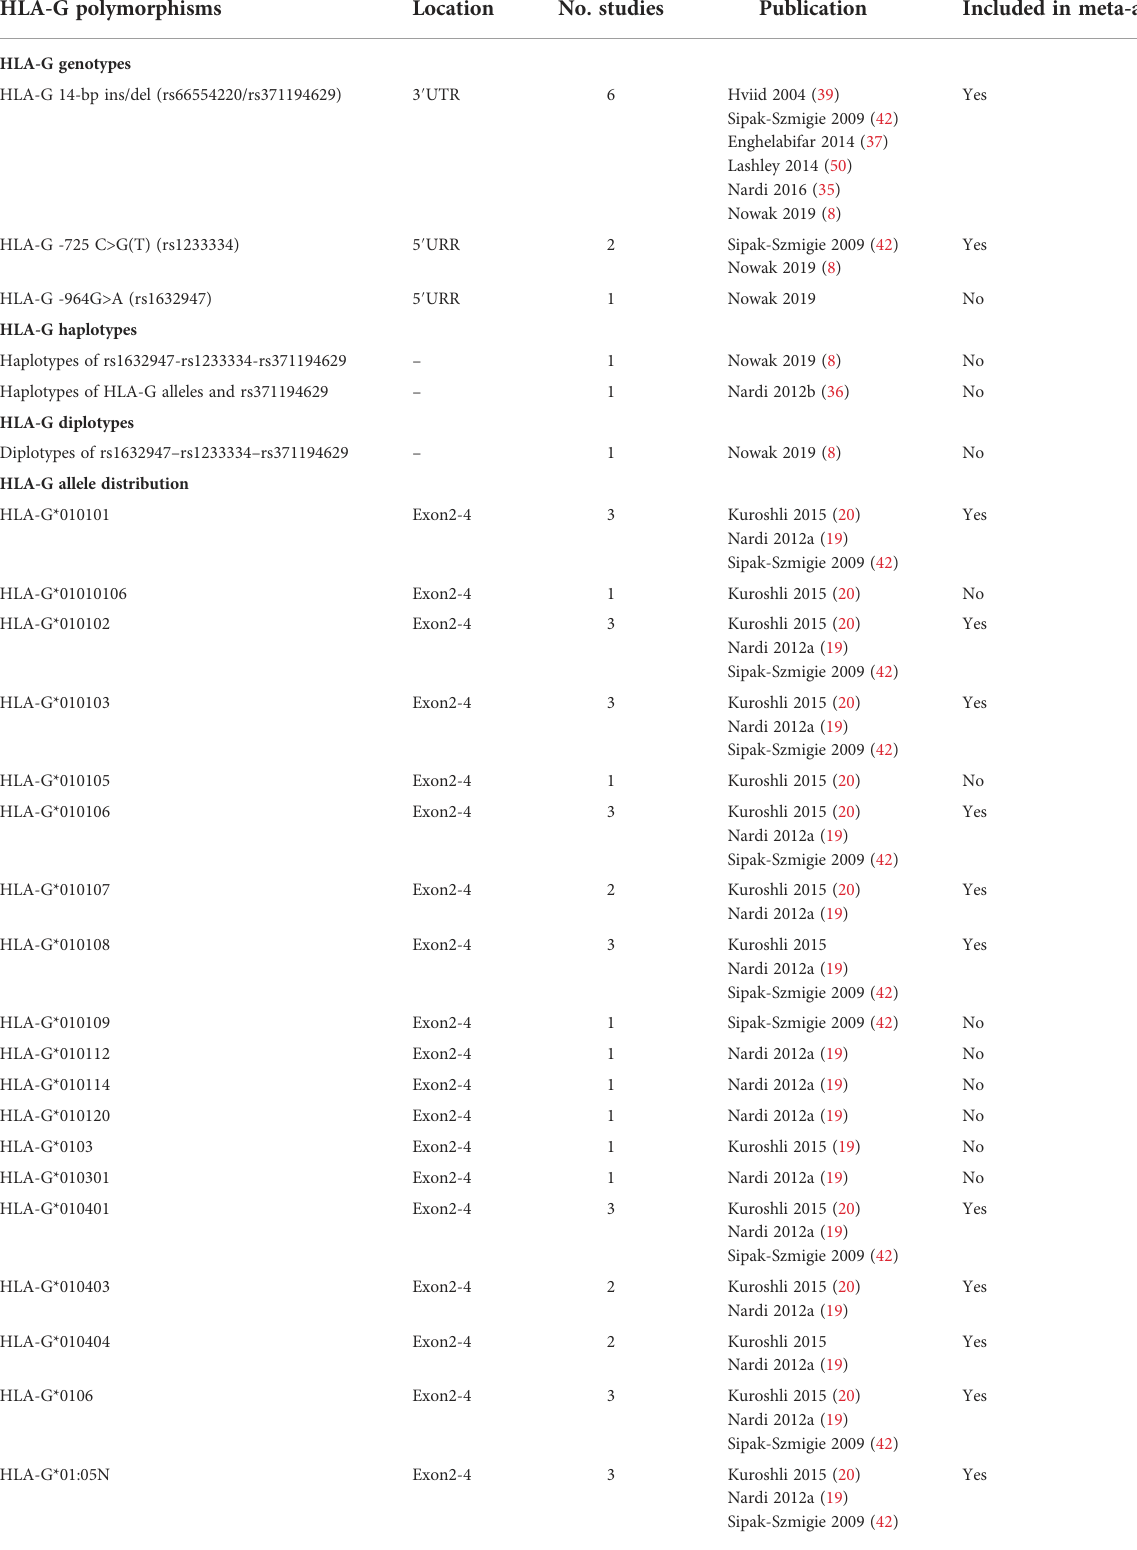
TABLE 1 Summary of the HLA-G polymorphisms that have been reported in RIF